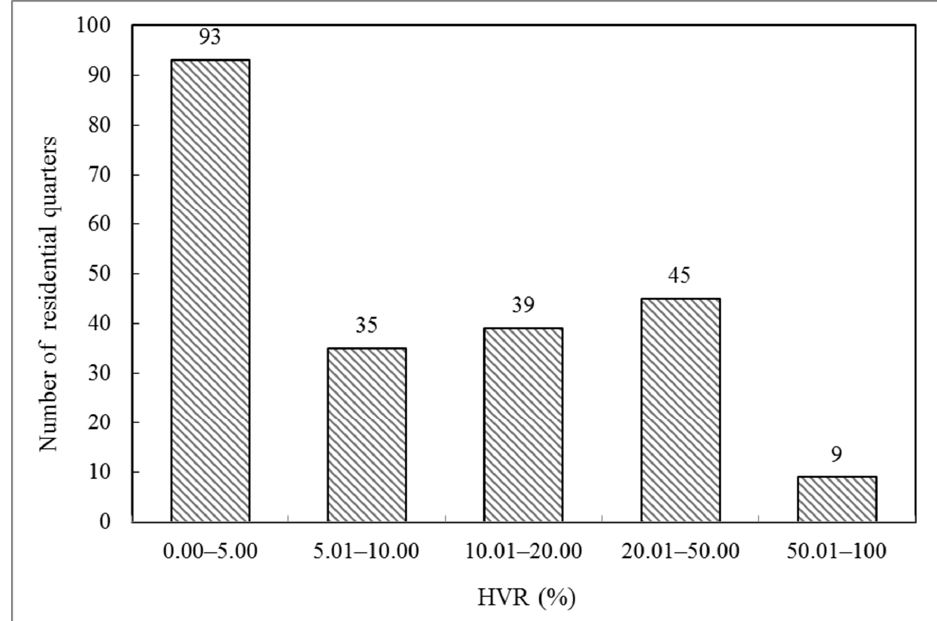
Figure 3. Descriptive statistical analysis of HVR in Guangzhou metropolitan area.